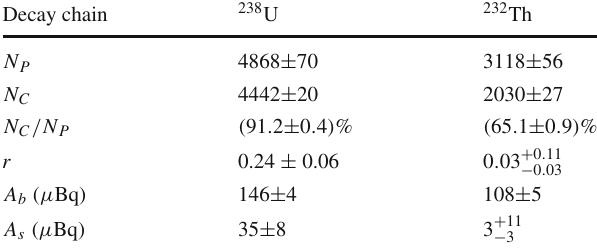
Table3 Experimentalinputandfinalresultsofthedelayedcoincidence analysis. Both for 238 U and 232 Th decay chain we quote: the number of parent candidates ( N P ), net of background subtraction; the number of detected coincidences ( N C ) with their binomial uncertainties; the ratio between surface and bulk contamination activities ( r ) and their absolute values ( A b , A s ). We quote the r result for 232 Th chain with an asymmetric uncertainty range to exclude negative non-physical values Decay